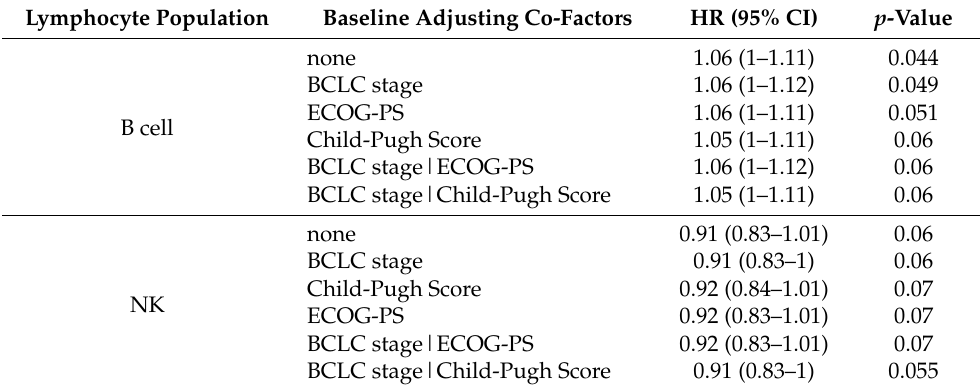
Table 2. Time-dependent multivariate Cox regression models between B and NK lymphocyte percentages and the probability of developing early dermatologic adverse events (eDAEs) during the first 8 weeks of sorafenib